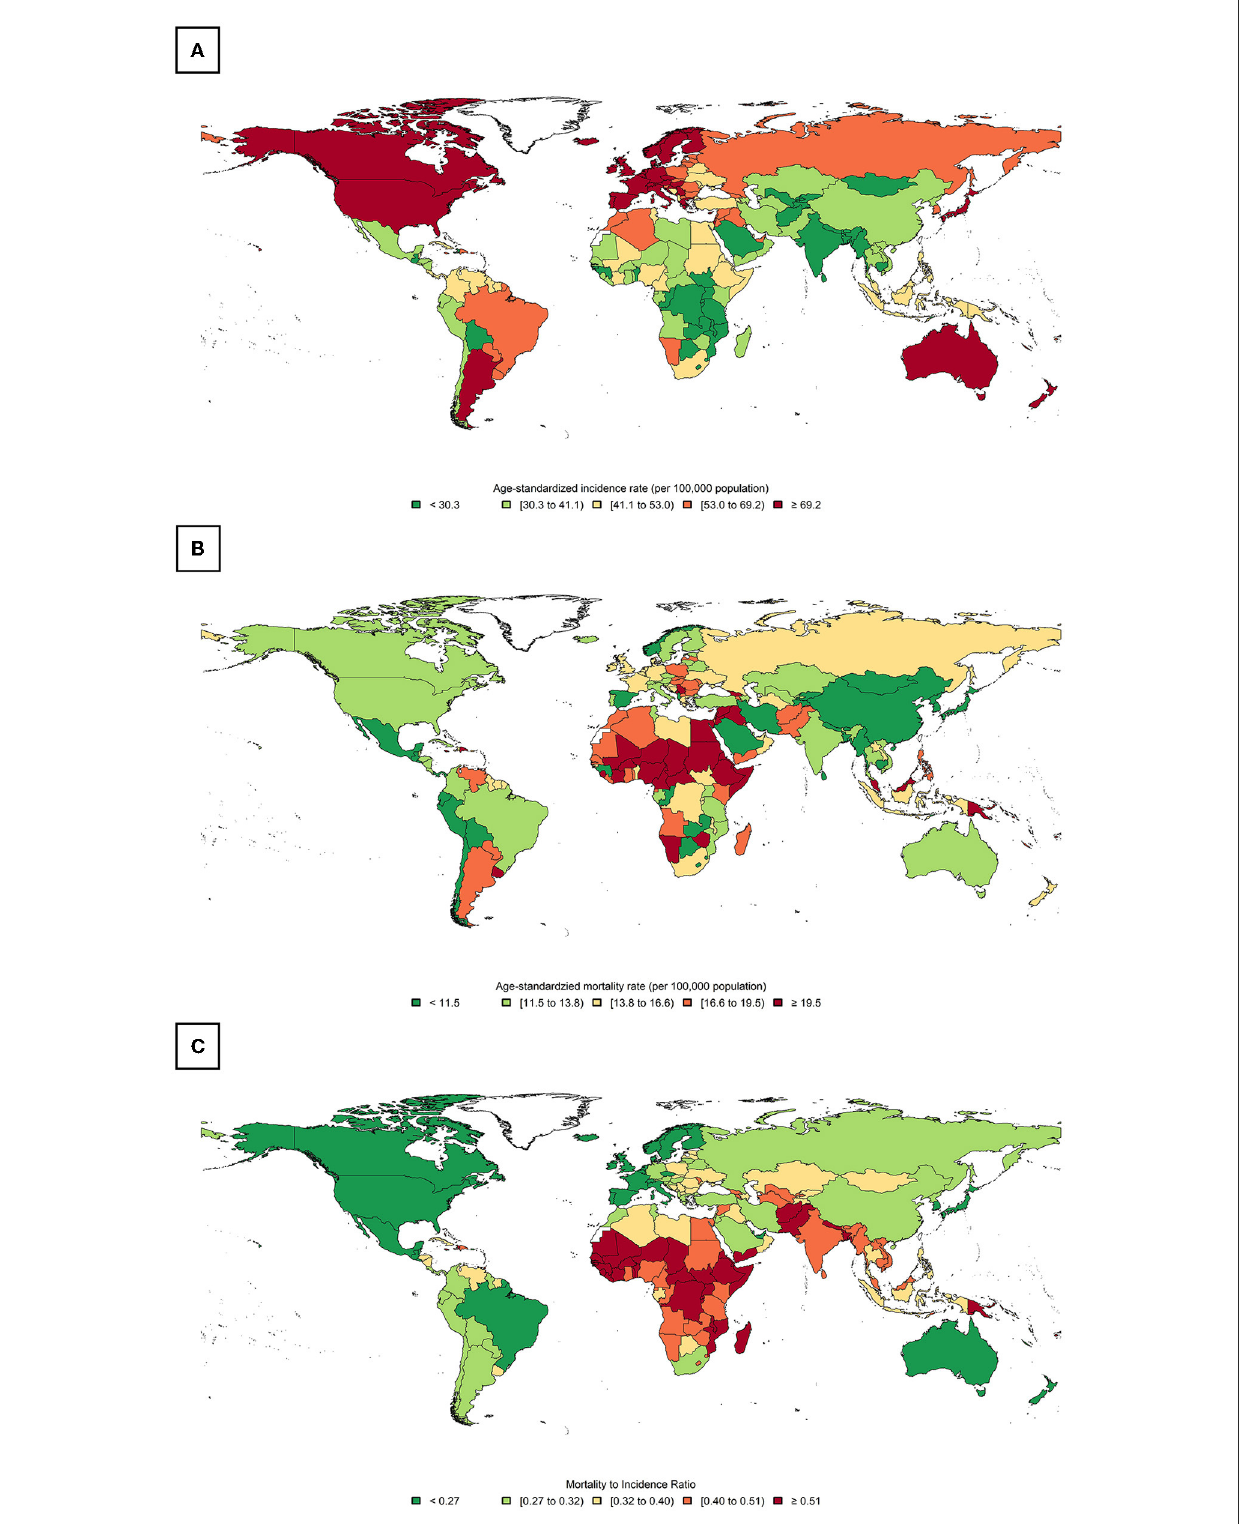
FIGURE2 Global distribution of breast cancer (BC): (A) age-standardized incidence rate (ASIR), (B) age-standardized mortality rate (ASMR), and (C) the calculated mortality-to-incidence ratio